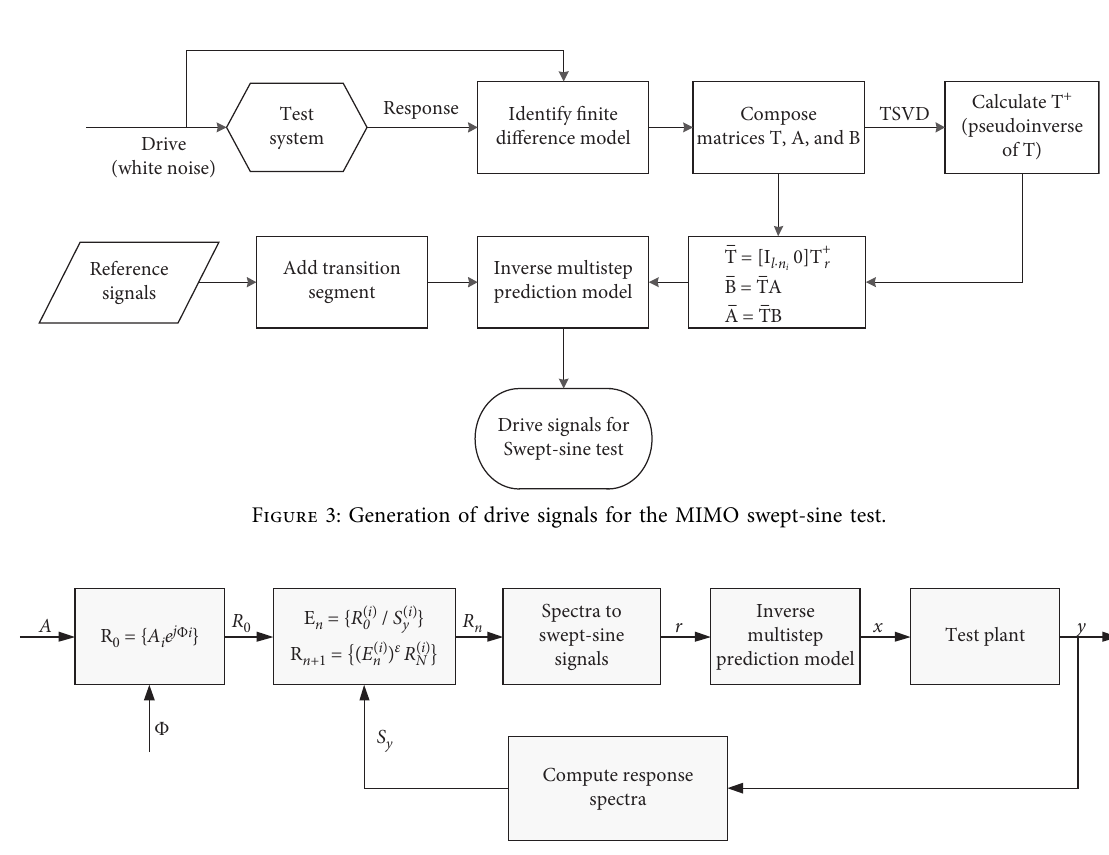
Figure 4: Offline swept-sine control scheme where A and Φ are amplitude and initial phase vectors defined in reference spectra. Table 1: Physical properties of the